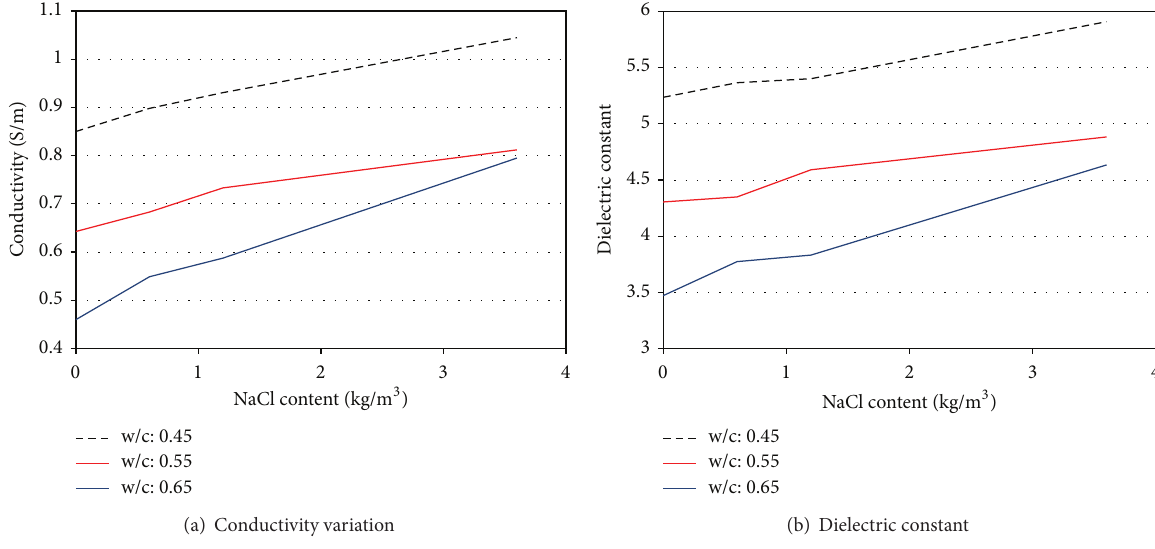
Figure 11: Effect of chloride contents on conductivity and dielectric